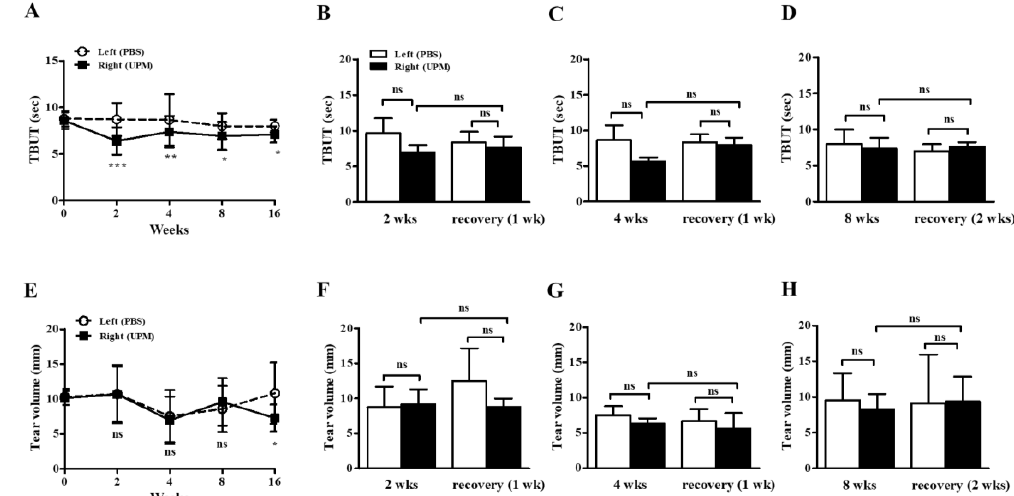
Figure 3. E ff ect of UPM on TBUT and tear volume according to exposure period. The TBUT values were measured at 2, 4, 8 and 16 weeks ( A ), after one week of rest one at 2 weeks ( B ) or 4 weeks ( C ), and after two weeks of rest at 8 weeks ( D ). The wet lengths of thread were expressed as tear volume measured at 2, 4, 8 and 16 weeks ( E ), after one week of rest at 2 weeks ( F ) or 4 weeks ( G ), and after two weeks of rest at 8 weeks ( H ). Data are expressed as the mean ± SD. * p < 0.05, ** p < 0.01, *** p < 0.001 vs. left eye at the same time point; ns, not significant.